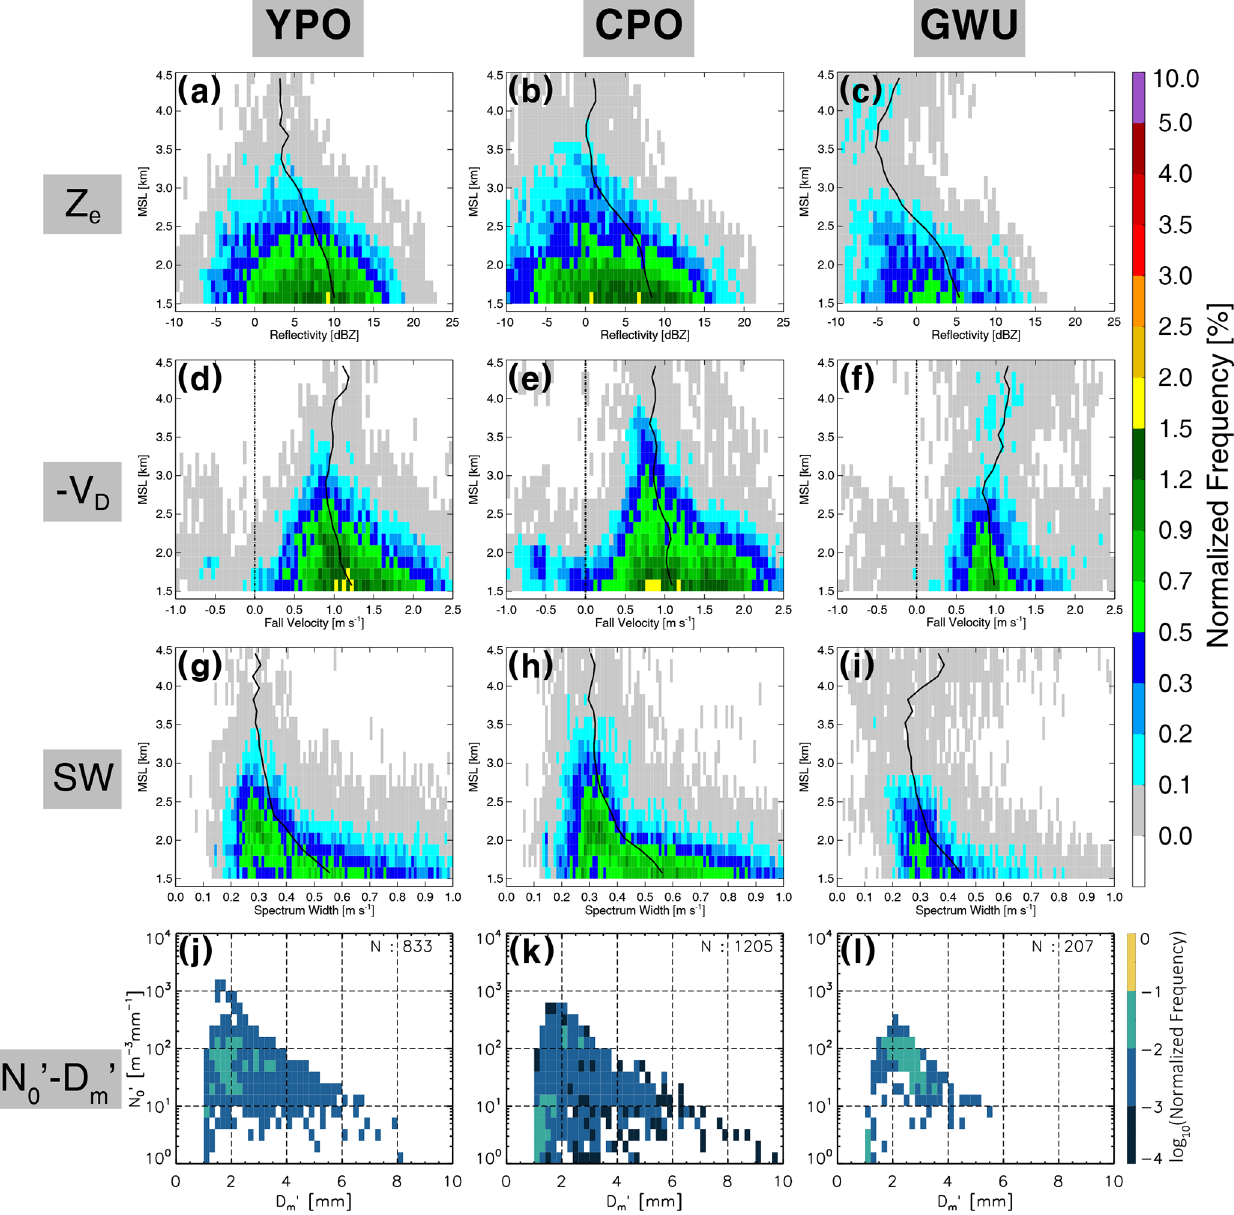
Figure 9. Same as in Fig. 7 except for the cold-low events. The mean liquid-equivalent precipitation rate from the Z e –SR relationship at 24.23GHz (Souverijns et al., 2017) at 1.5km height is 0.59, 0.42, and 0.22mmh − 1 for YPO, CPO, and GWU, respectively.